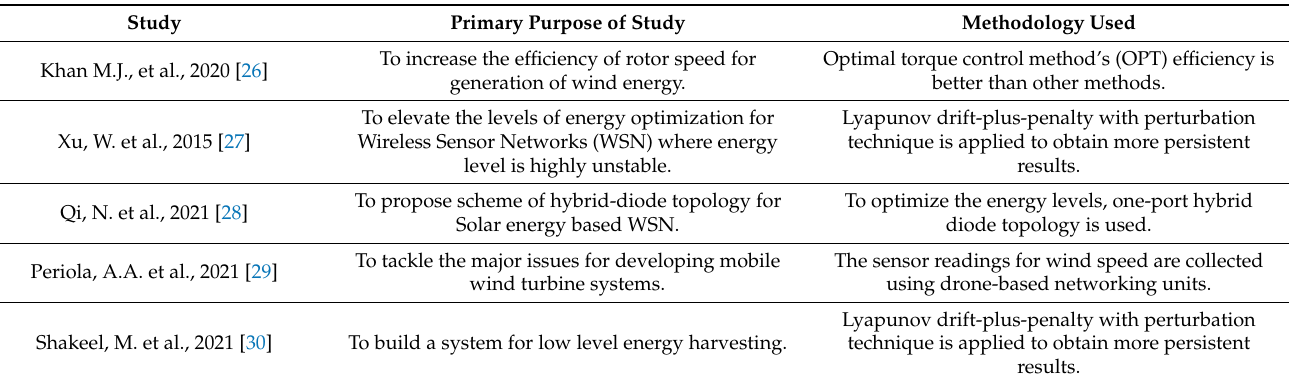
Table 2. Comparative study for analysis of power optimization for low-energy based sensor used in wireless sensor networks.